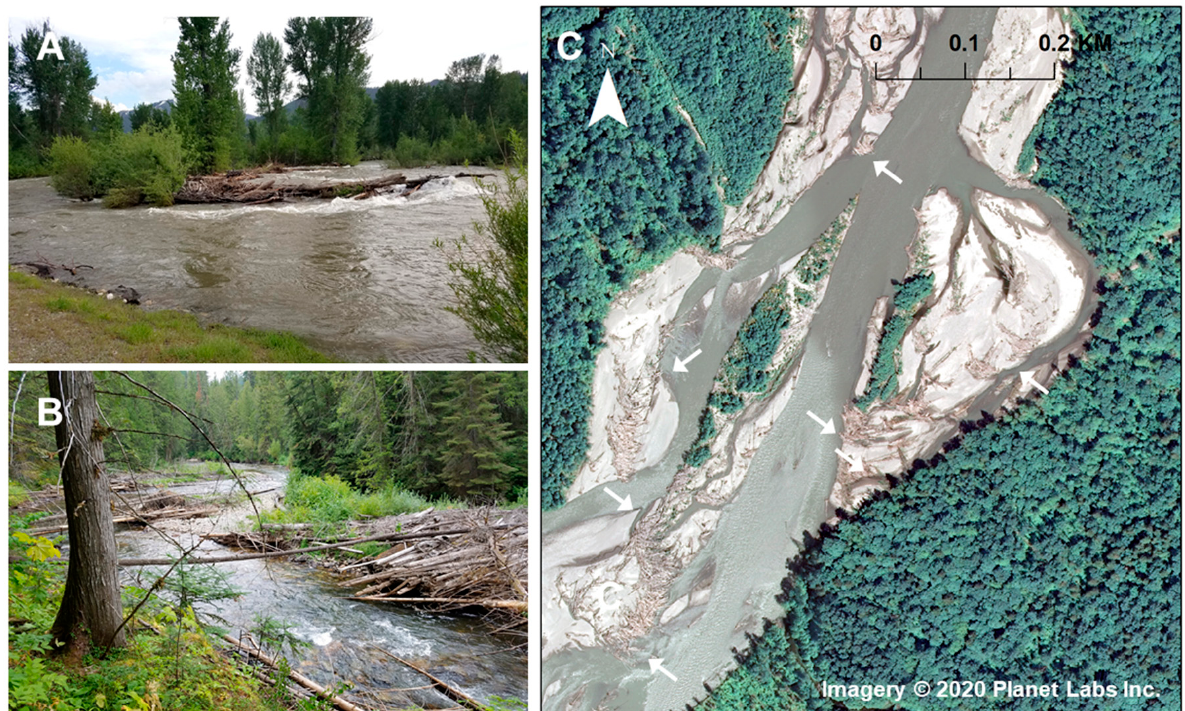
Figure 7. Large wood and longitudinal connectivity in forested fluvial systems: ( A ) wood and riparian vegetation influence flow resistance (flow right to left); ( B ) logjams develop in association with bars and steer the flow (flow right to left); ( C ) large wood in a large channel—major accumulations marked with white arrows, often forming “hard points” at bar heads (flow from the bottom to the top). ( A – C ) Note patches of colonizing vegetation associated with logjams. Image source in ( C ): Planet Team [196].